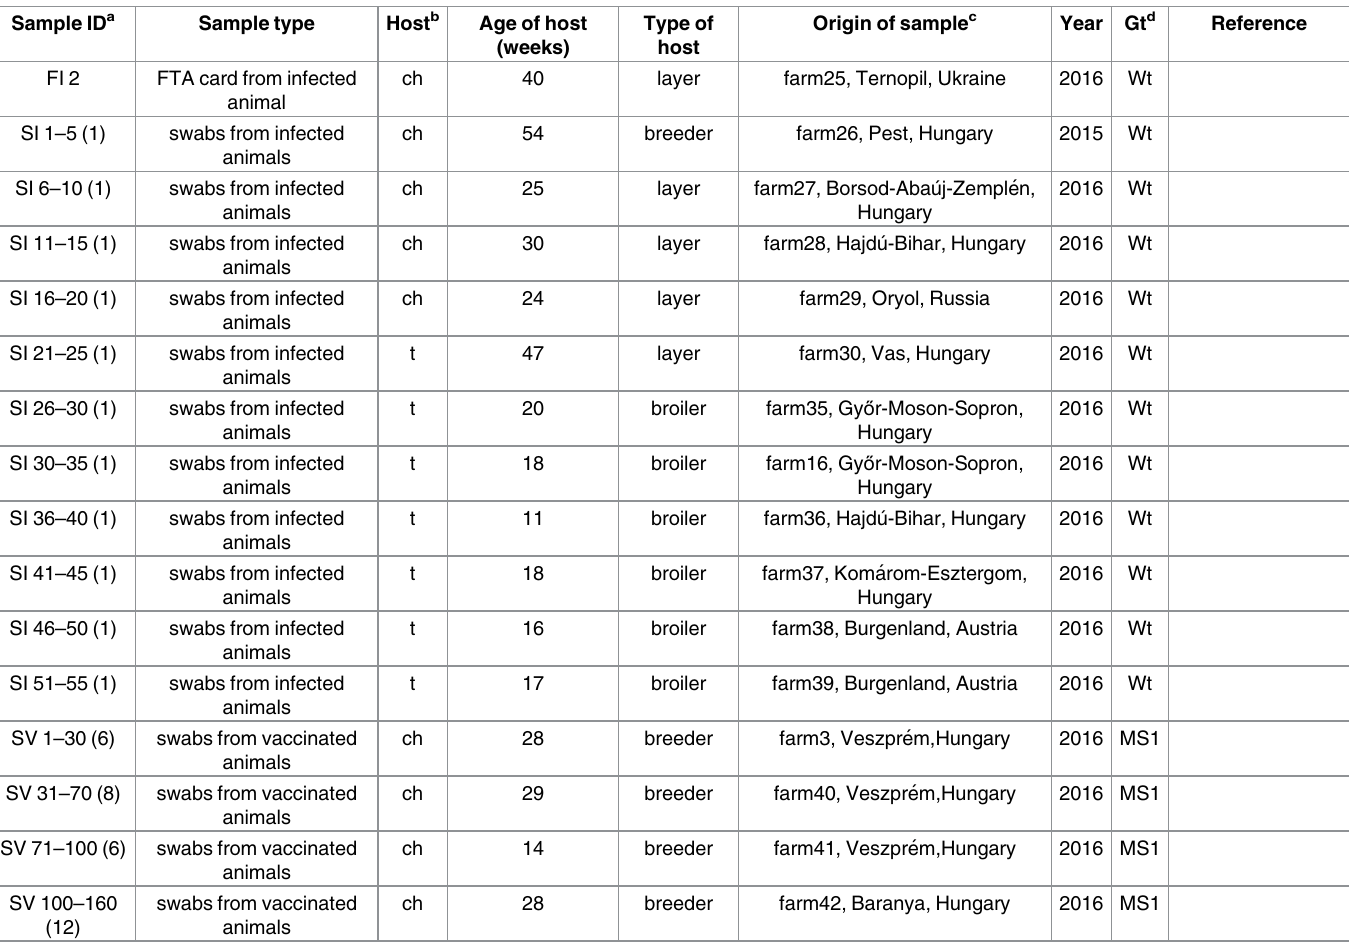
a DNA from swab samples were gained in DNA pools (each pool contained 5 swabs); numbers in brackets represent the number of DNA pools examined b all samples were collected from the trachea of the animals; ch: chicken, t: turkey c farm, region and country of origin of the samples